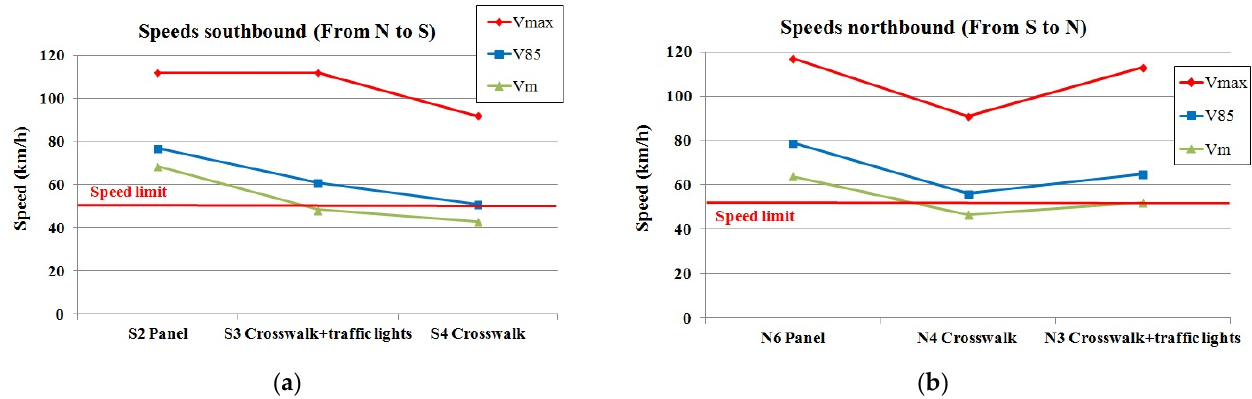
Figure 9. Speed at each controlled point in Arrespalditza/Respaldiza (Spain): ( a ) southbound, ( b ) northbound.